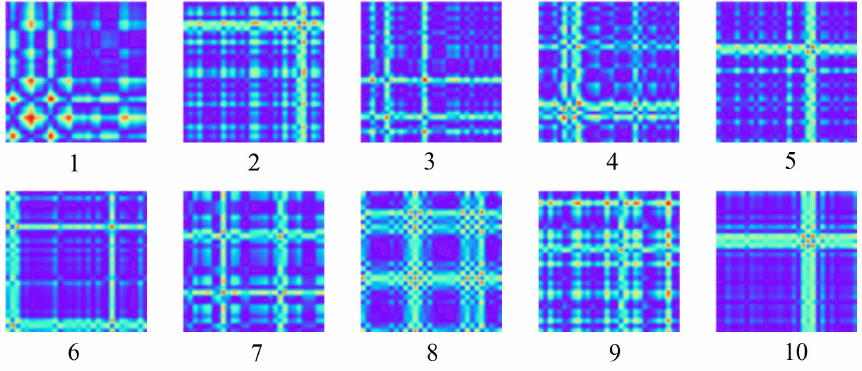
Figure 13. The GAF images of Dataset A.